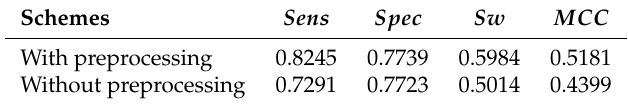
Table 5. Performance comparison of the schemes with and without preprocessing.